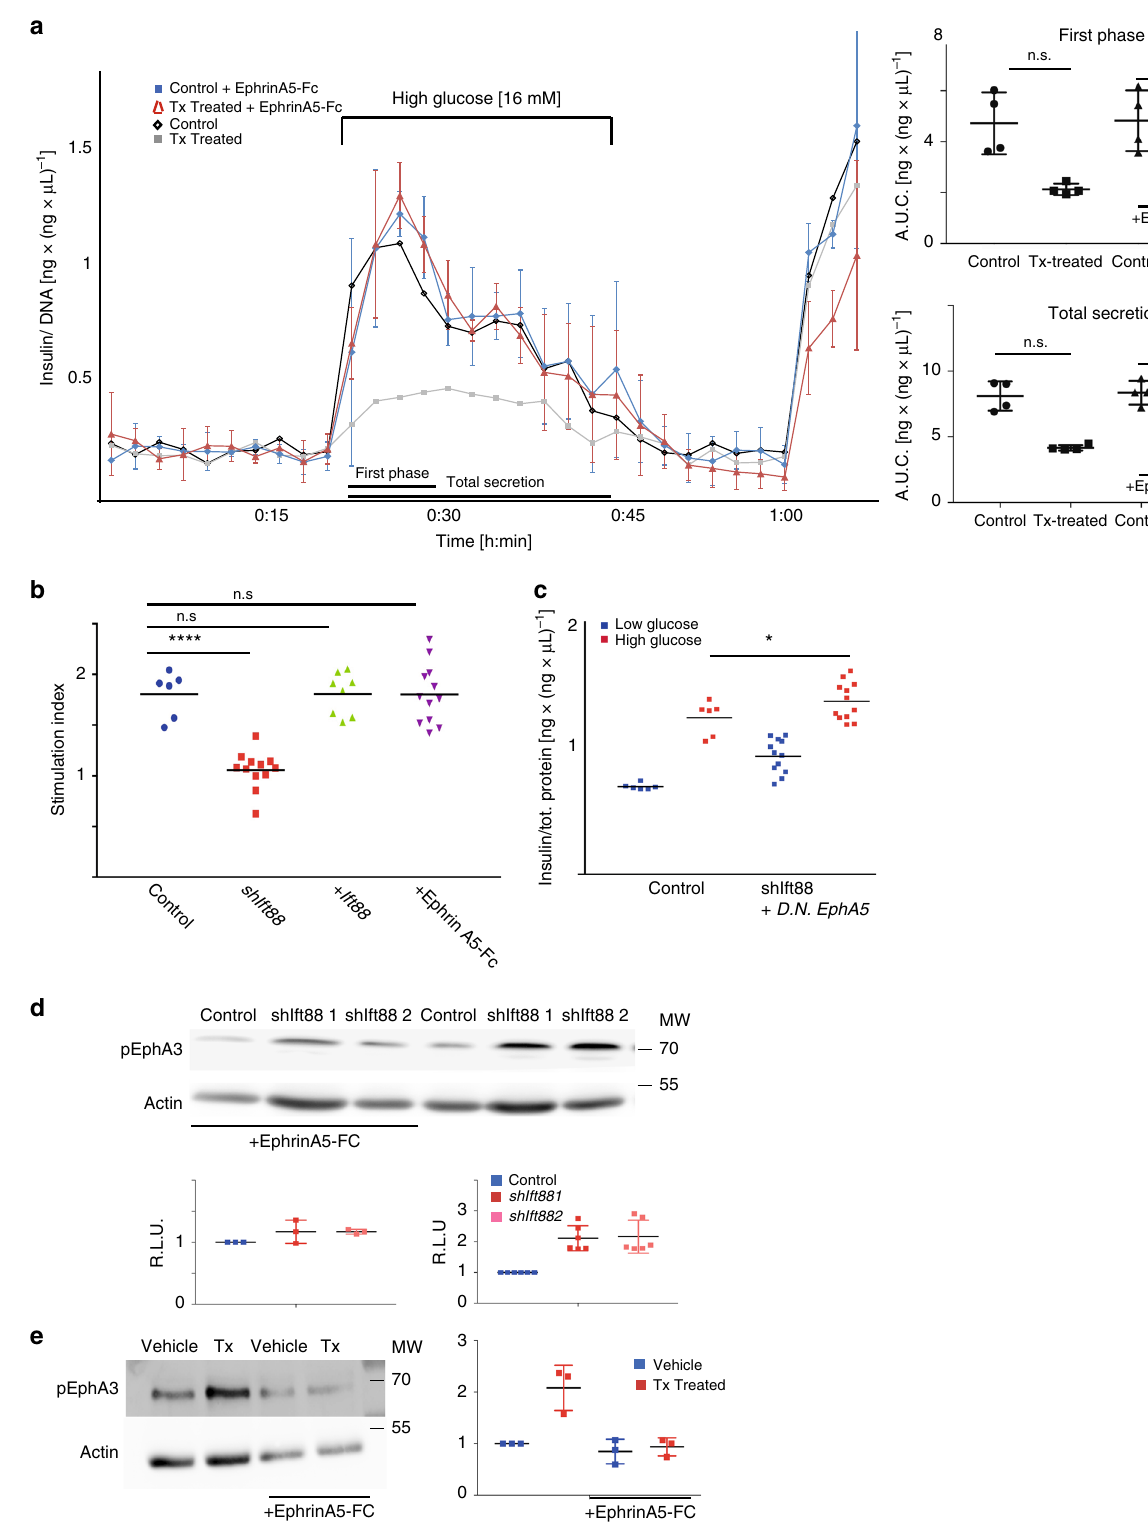
EphrinA5-Fc = 120% compared with control, shIft882 + EphrinA5- Fc = 117% compared with control ( n = 6)). Similarly, we found reduced pEphA3 levels in Tx-treated β ICKO islets 1 h after EphrinA5-Fc stimulation (Fig. 3e). This observation suggests that EphA3 hyperphosphorylation blocks insulin secretion and that EphrinA5-Fc treatment restores